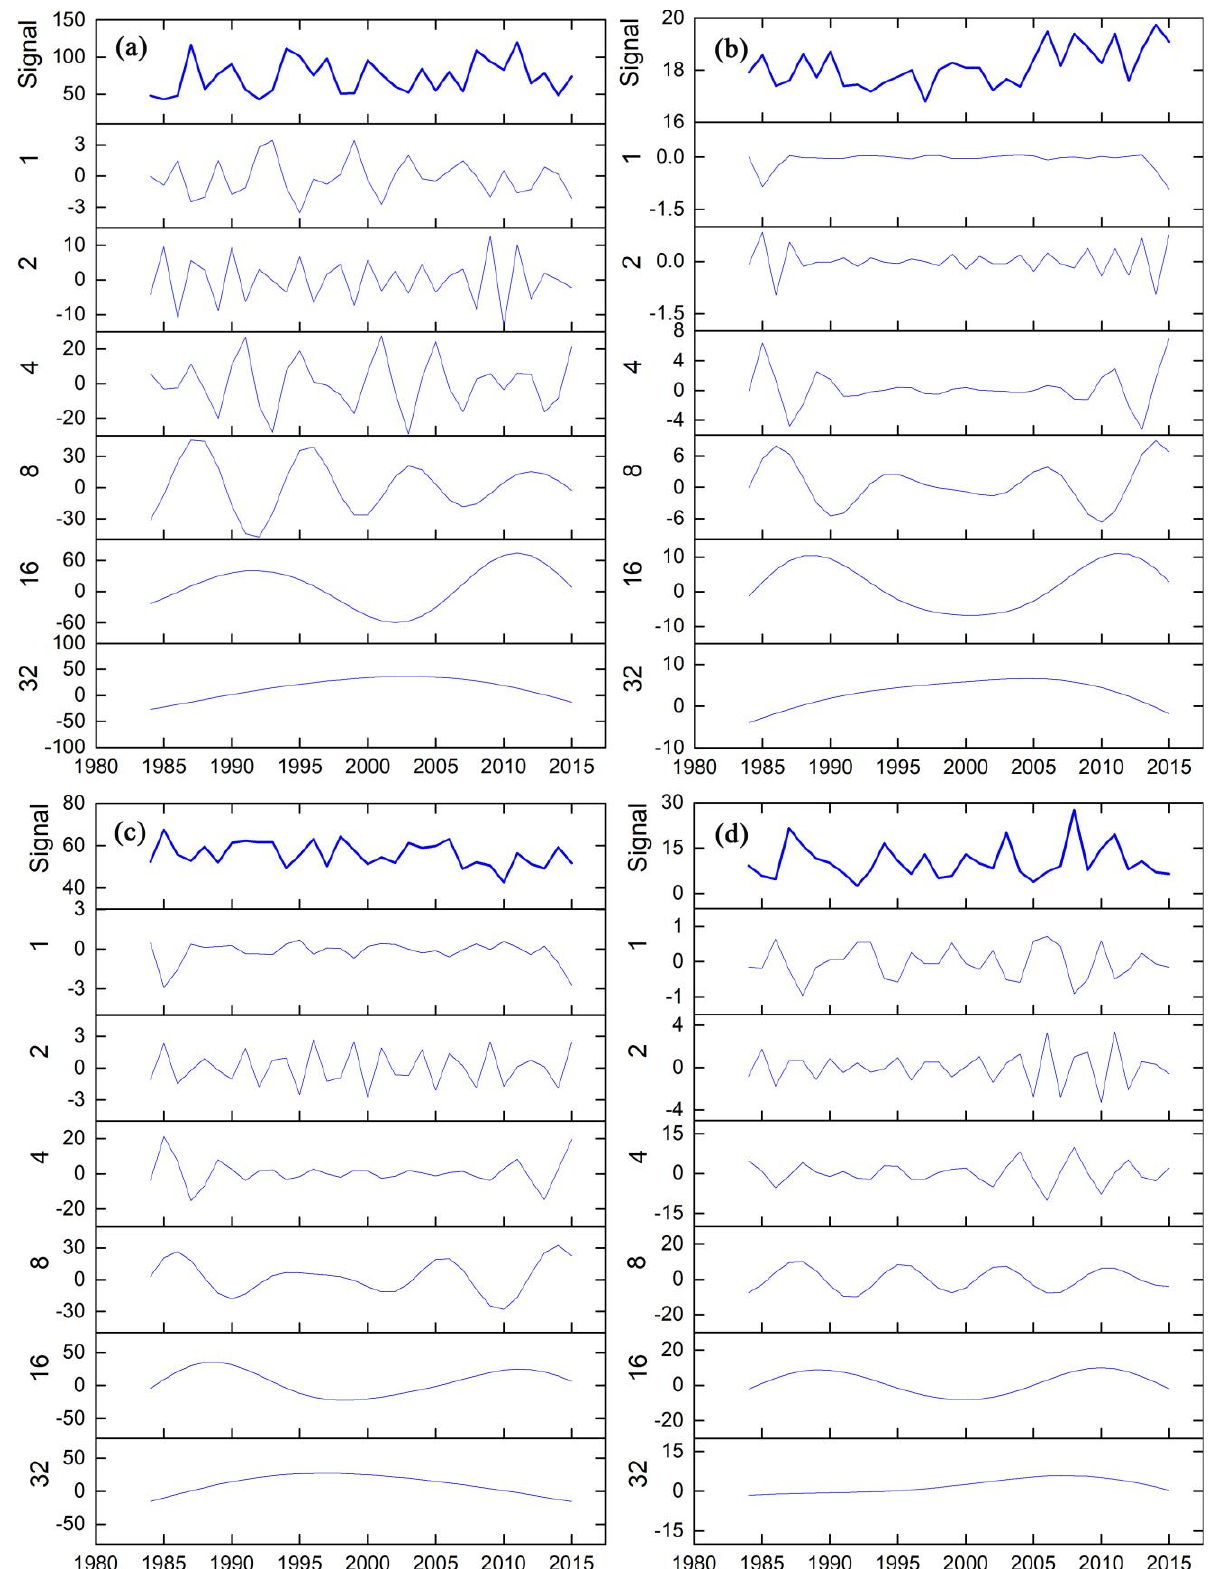
Figure 6. Multi-time-scale variations of rainfall ( a ), temperature ( b ), evaporation ( c ) and runoff ( d ) in autumn.